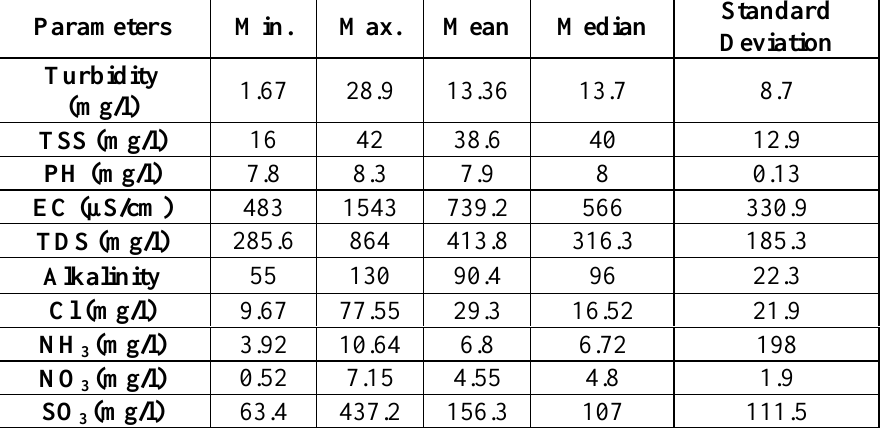
Table 2: Statistics of Physio-Chemical water parameter.